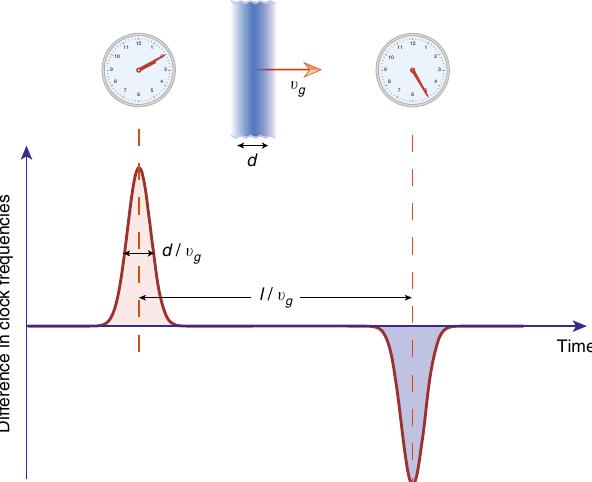
Fig. 2 Time dependence of the dark matter-induced signal. The frequency difference between two identical ideal clocks separated by distance l . The time delay in the signals encodes the kinematics of the dark matter